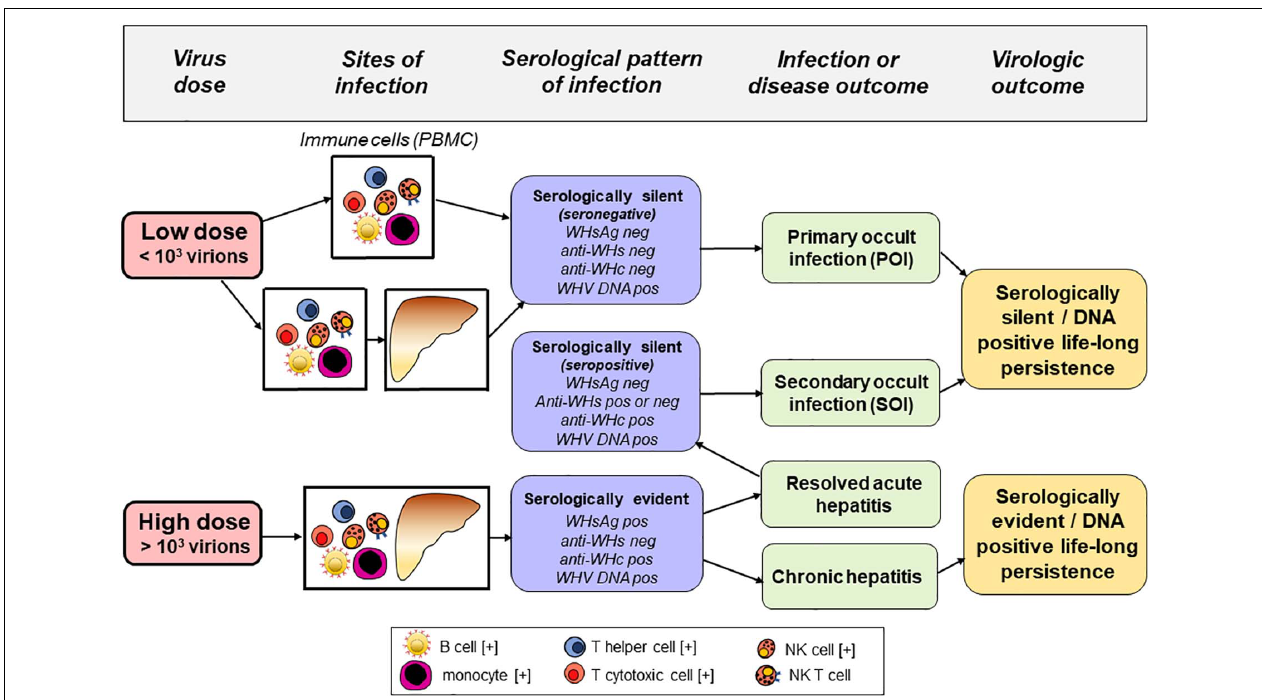
FIGURE 1 | Sites of infection, serological (immunovirological) and molecular (DNA) profiles, and outcomes of hepadnaviral infection in the woodchuck model of hepatitis B after intravenous inoculation with very low (liver non-pathogenic) or high (liver pathogenic) dose of WHV. Cell types found infected with HBV and/or carrying HBV DNA integration in patients with chronic hepatitis B are marked with